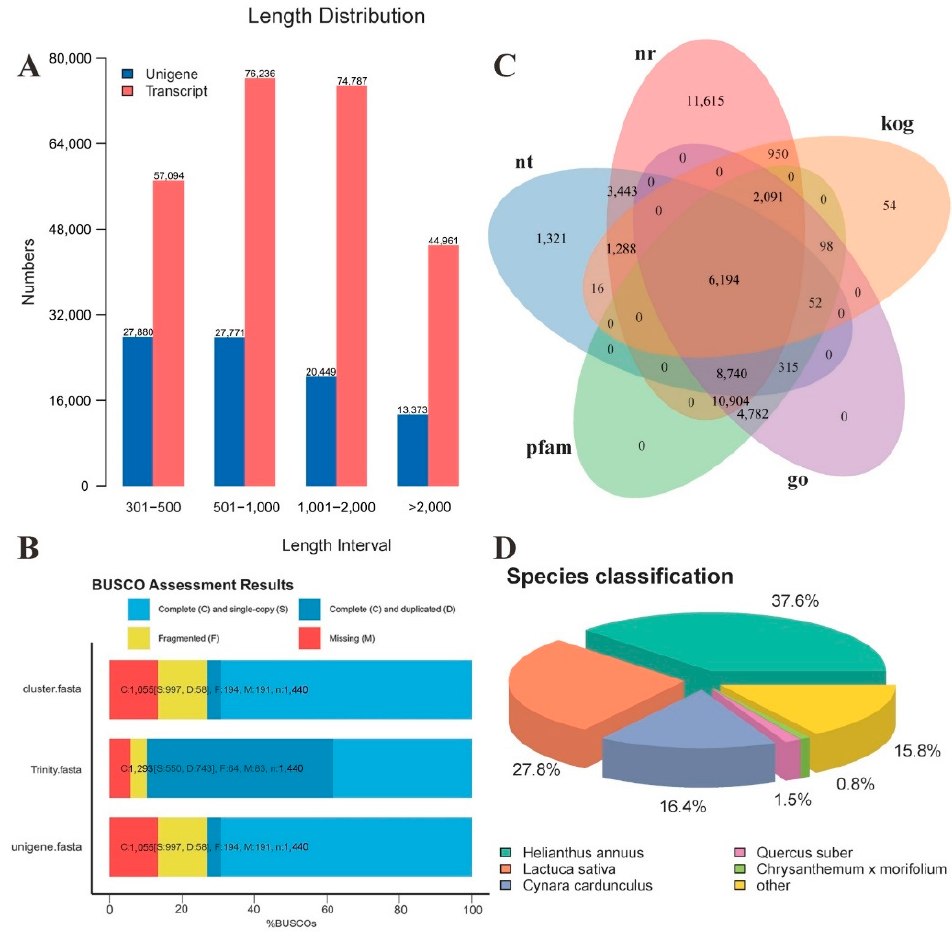
Figure 1. Transcriptome assembly and gene functional annotation. ( A ) Length distributions of assembled transcripts and unigenes; ( B ) BUSCO assessment results; ( C ) total number of functional annotations in Nt, Nr, KOG, GO, and Pfam databases; ( D ) species distribution of the BLASTX result against the Nr database.